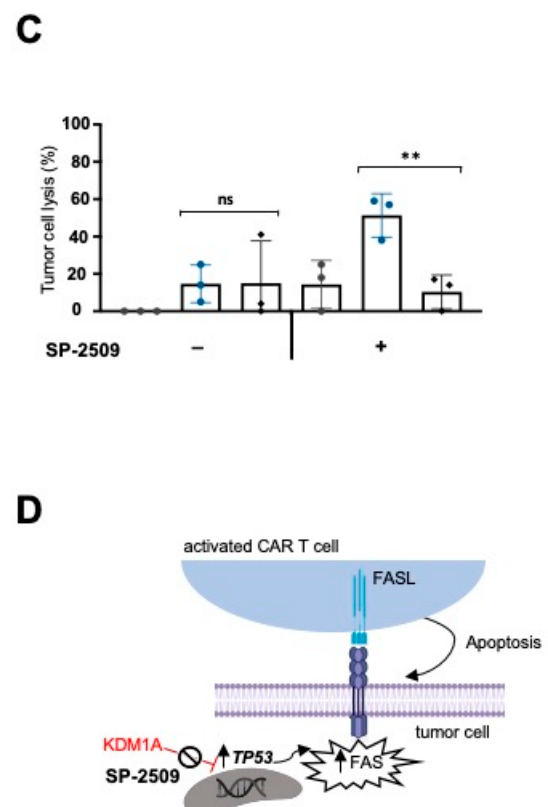
Figure 3. Combining KDM1A inhibition with CAR T cell therapy killed neuroblastoma cells expressing low tumor antigen levels via the FAS-FASL axis. ( A ) Experimental timeline for the combination therapy. ( B ) Killing efficacy of L1CAM-specific CAR T cells after 24 h coculture of neuroblastoma cell lines treated with 0.5 µM SP-2509 (or untreated controls) at an effector:target ratio of 1:5 (mean ± SD, n = 3). ( C ) Untreated or KDM1A-pretreated SH-SY5Y cells were incubated for 1 h in the presence or absence of the human neutralizing anti-FAS antibody before measuring the tumor cell lysis by L1CAM-specific CAR T cells cocultured with the tumor cells at an effector:target ratio of 1:5 for 24 h (mean ± SD, n = 3). ( D ) Illustration of FAS regulation in tumor cells. ns not significant * p ≤ 0.05, ** p ≤ 0.01.